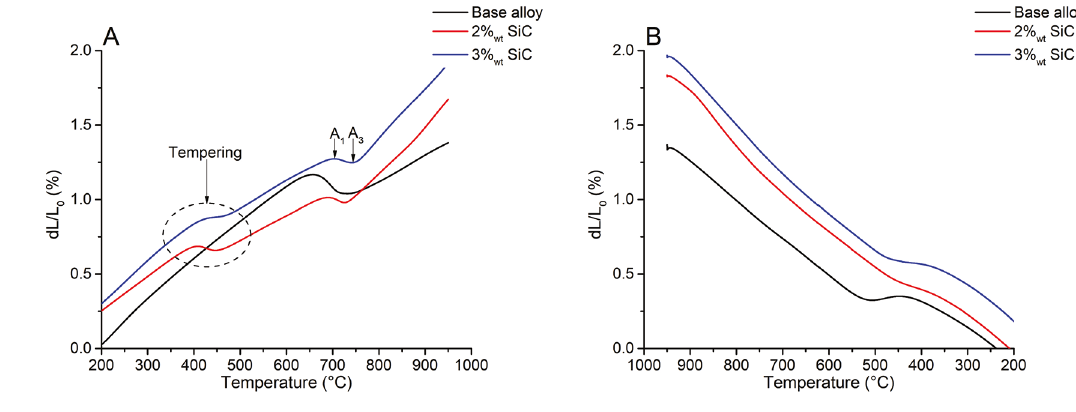
Figure 3. Dilatometric curves of heating (a) and cooling (b).